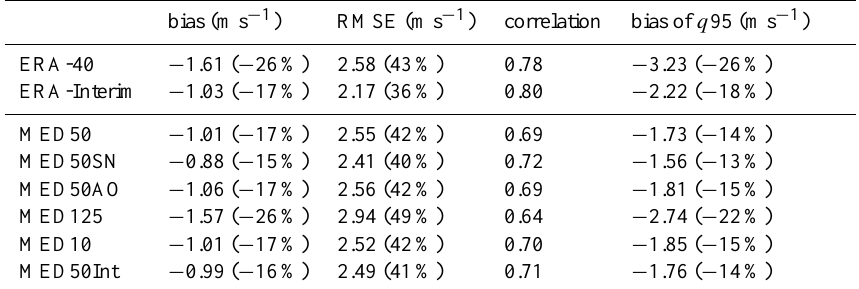
Table 2. Mean values over 2000–2001 and over the whole Mediterranean Basin for the bias, the RMSE, the temporal correlation and the 95th percentile bias of the daily wind speed compared with QuikSCAT for ERA-40, ERA-Interim and each ALADIN-Climate simulation. Percentages indicate the ratio relative to QuikSCAT mean value (for bias and RMSE) and q 95 value (for q 95 bias).